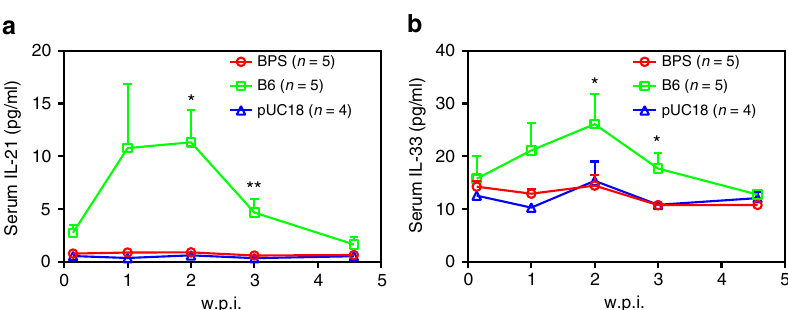
Fig. 5 Serum IL-21 and IL-33 are stimulated in B6 HDI mice but not BPS HDI mice. Sera from BPS, B6 and pUC18 HDI BALB/c mice were collected at indicated time points and levels of selected cytokines quantitated using multiplex-based assay. Group means and s.e.m. within group of serum IL-21 ( a ) and IL-33 ( b ) measurements are presented with group sizes ( n ) indicated. BPS and B6 mice data are compared against pUC18 mice and statistical signi fi cance calculated using unpaired two-tailed t -test. * p < 0.05; ** p < 0.01. For data on other tested cytokines, see Supplementary Fig. 18. w.p.i. weeks